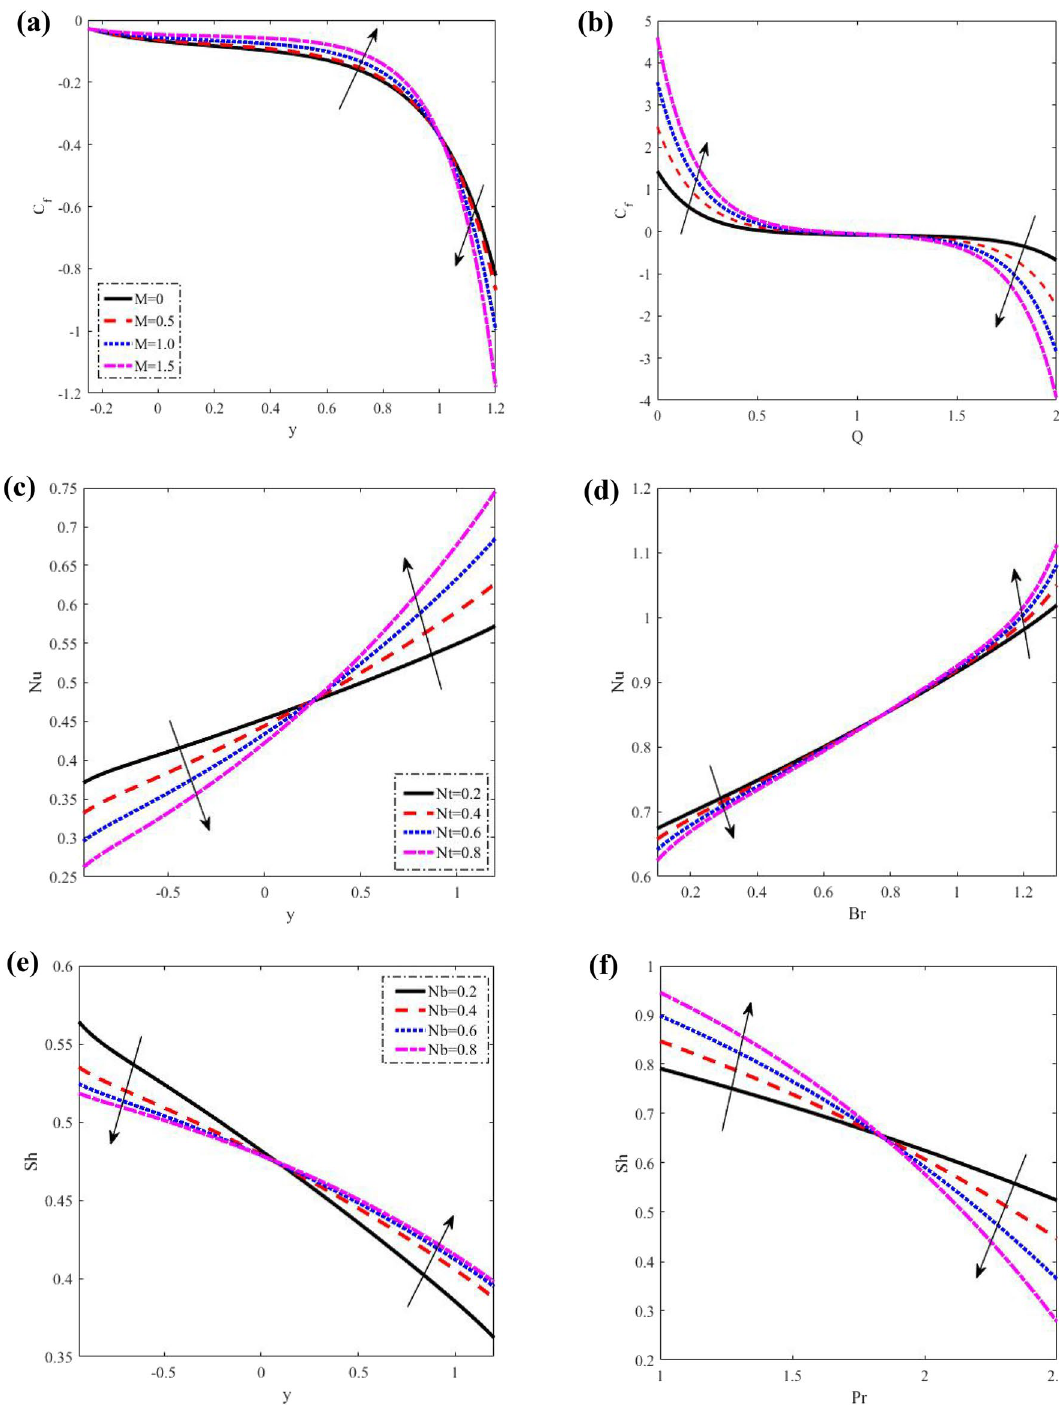
Figure 7. Discrepancies of the shear stress C f the heat flux Nu and the nanoparticle volume flux Sh . ( a ) Discrepancies of C f against M . ( b ) Discrepancies of C f against Q . ( c ) Discrepancies of Nu against Nt . ( d ) Discrepancies of Nu against Br . ( e ) Discrepancies of Sh against Nb . ( f ) Discrepancies of Sh against